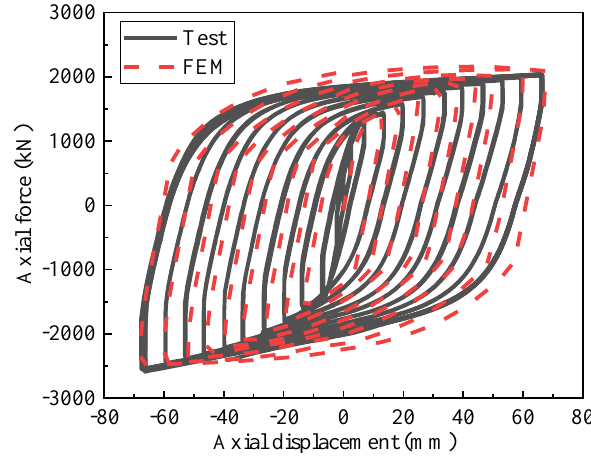
Figure 6. Calibrated hysteretic response of the steel material. Table 2. Parameters of the combined hardening model.